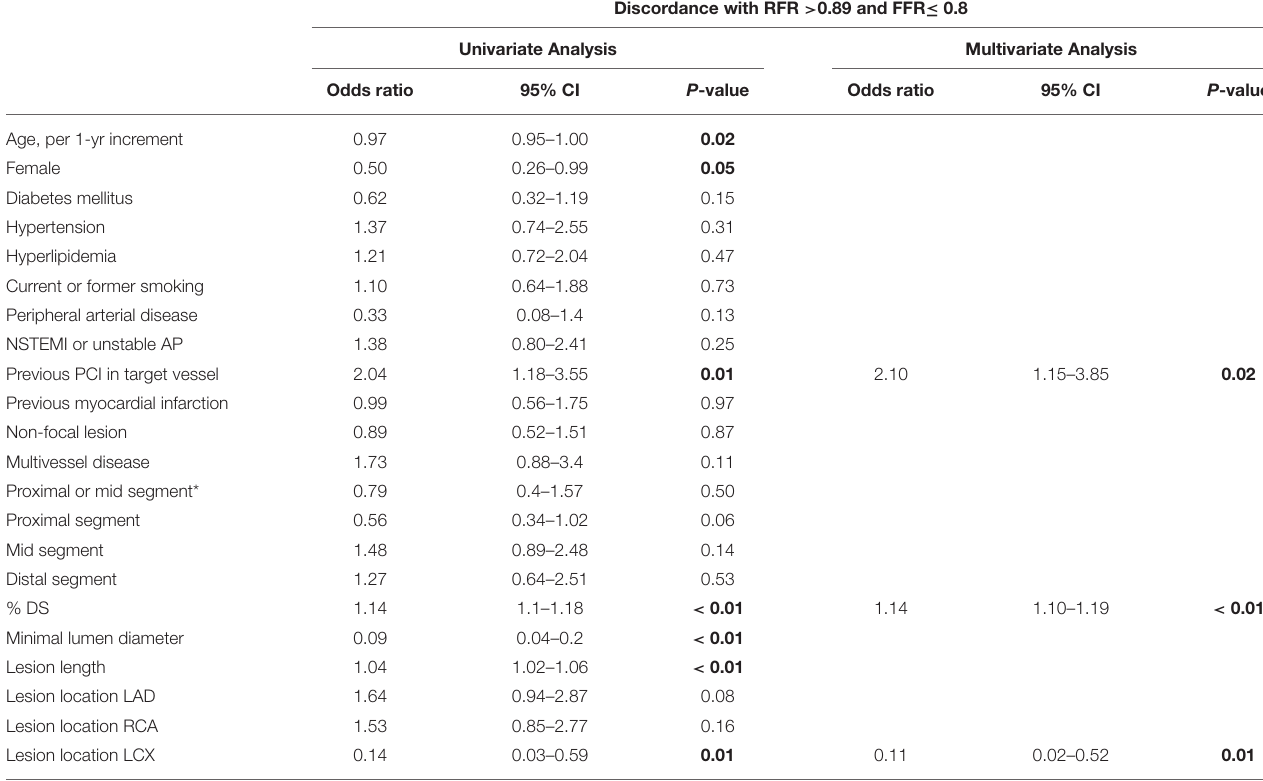
TABLE 4B | Independent predictors of disagreement between RFR and